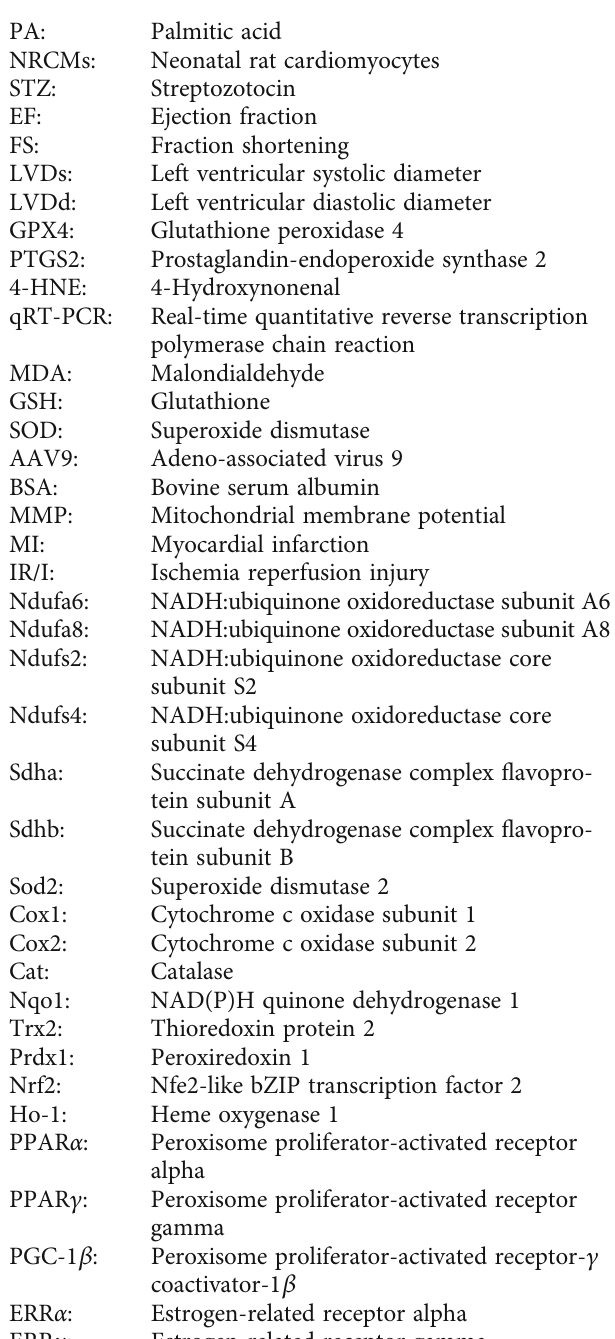
S1 representative Western blot of Nr2f2 expression